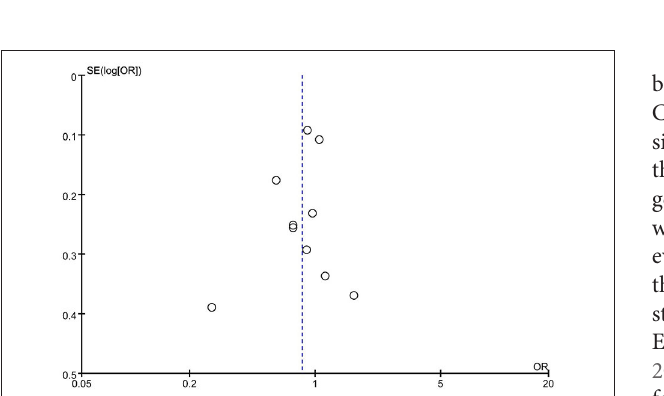
FIGURE 4 | Subgroup analysis of association between G1246A polymorphism in the HCRTR2 gene and CH.